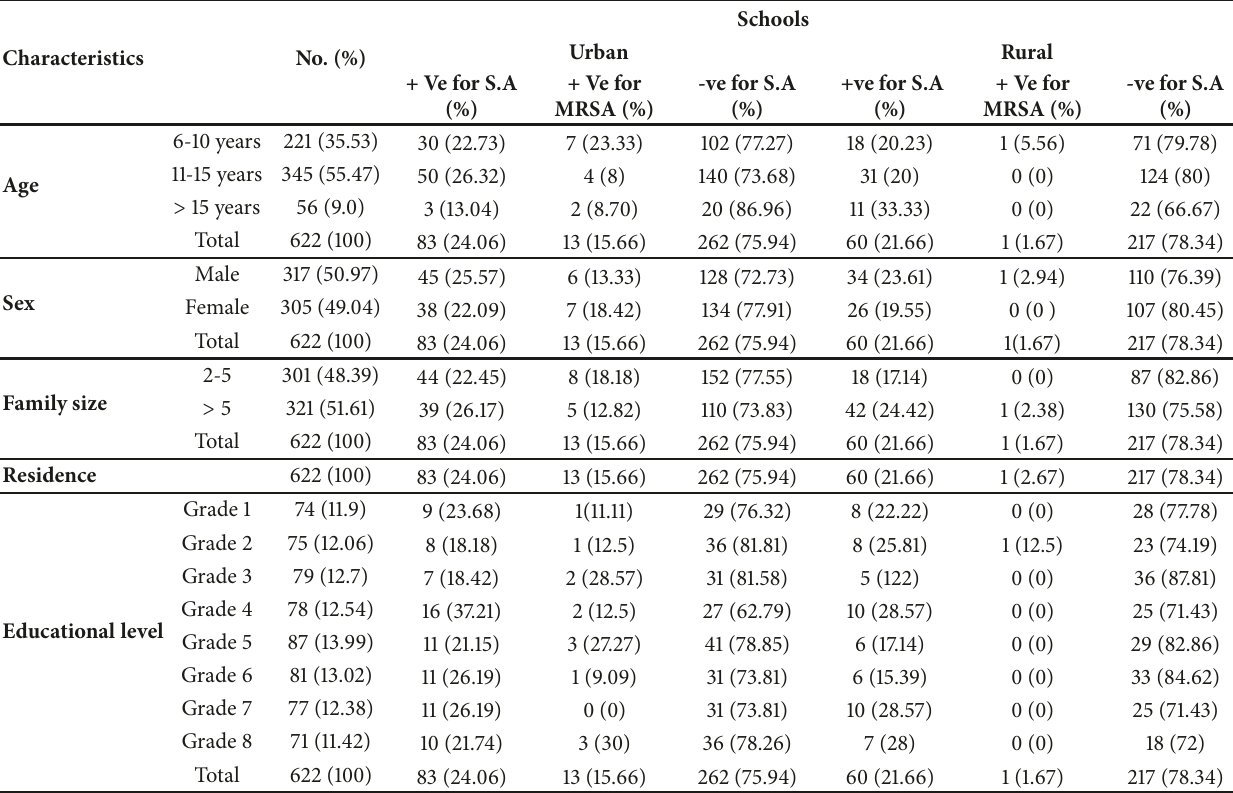
Table 2: Prevalenceof Staphylococcus aureus with special emphasis on MRSA among study participants in urban and ruralelementary school children in Gondar, Northwest Ethiopia, 2018.